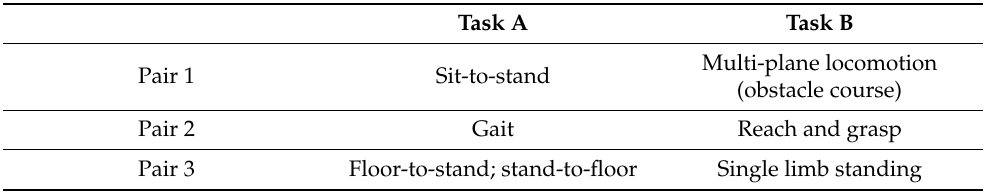
Table A1. Pairing of six functional tasks.